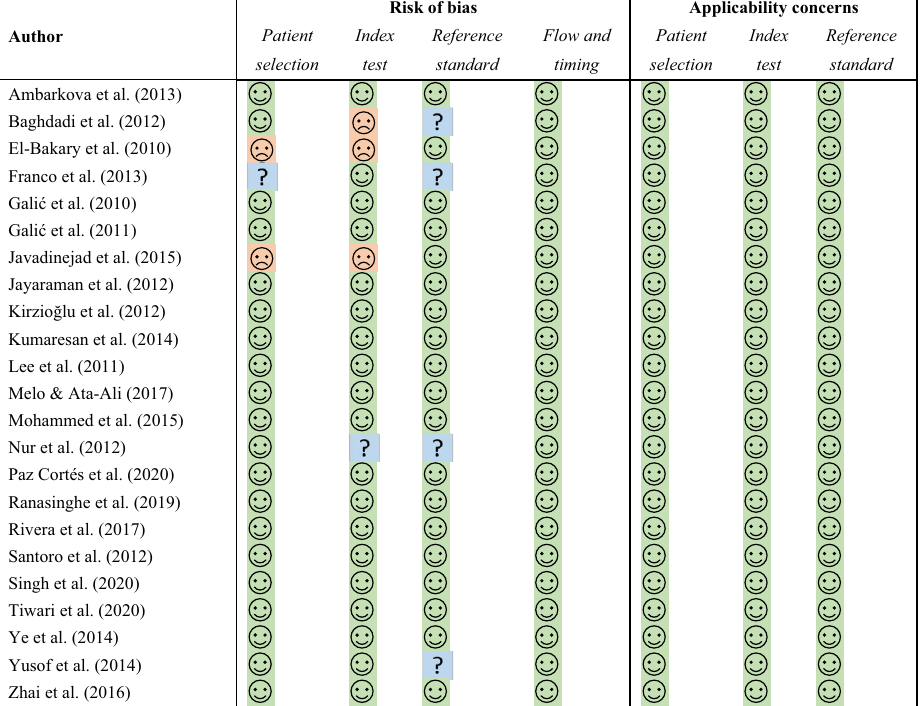
Table 2. Quality assessment performed using the QUADAS-2